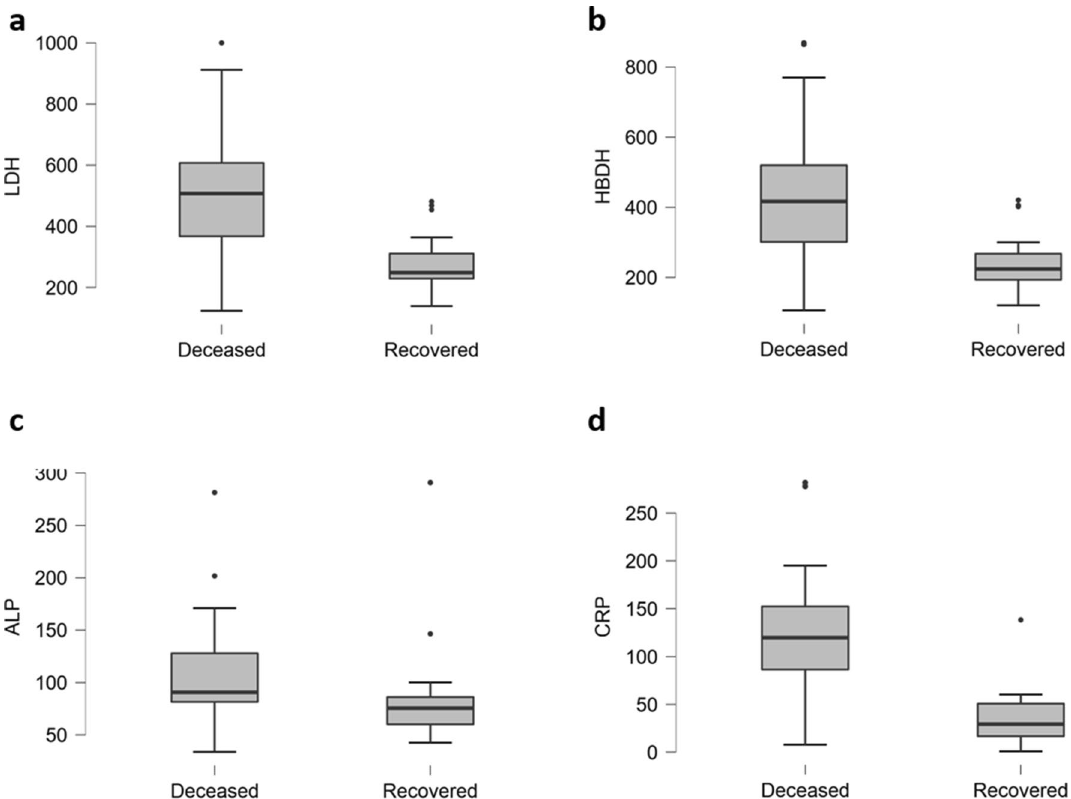
Figure 2. Hepatic biomarkers of deceased and recovered patients As compared to recovered patients, elevated levels of LDH ( a ), HBDB ( b ), ALP ( c ) and CRP ( d ) could be observed in deceased